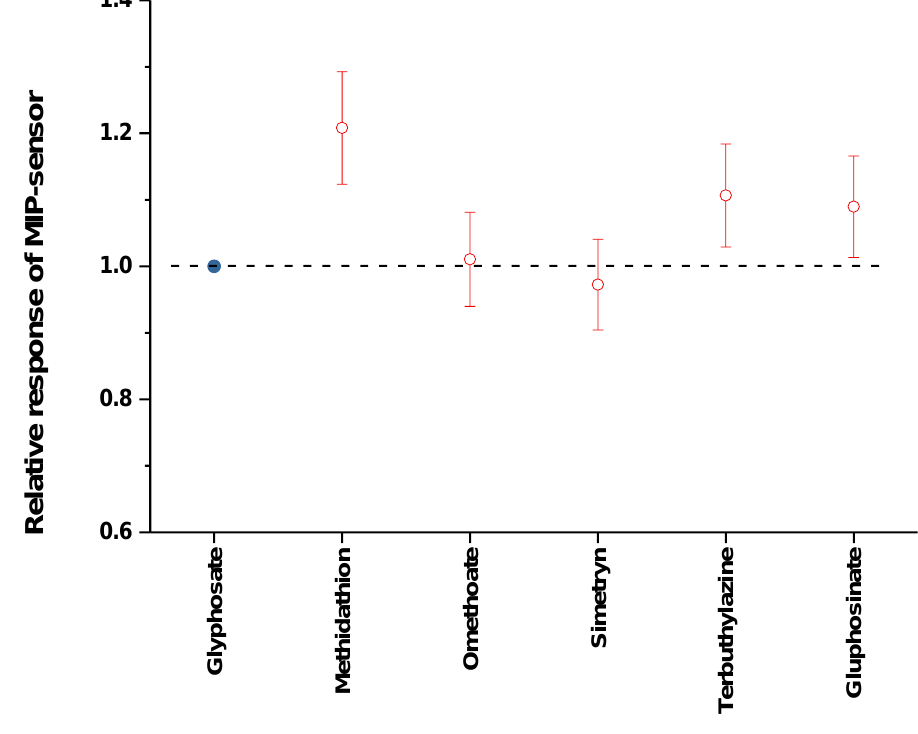
Figure 9. Relative electrochemical responses of MIP-sensor to gluphosinate ammonium, simetryn, terbuthylazine-2-hydroxy, omethoate, and methidathion at concentration of 10 − 4 M, compared to glyphosate’s response at 10 − 11 M.